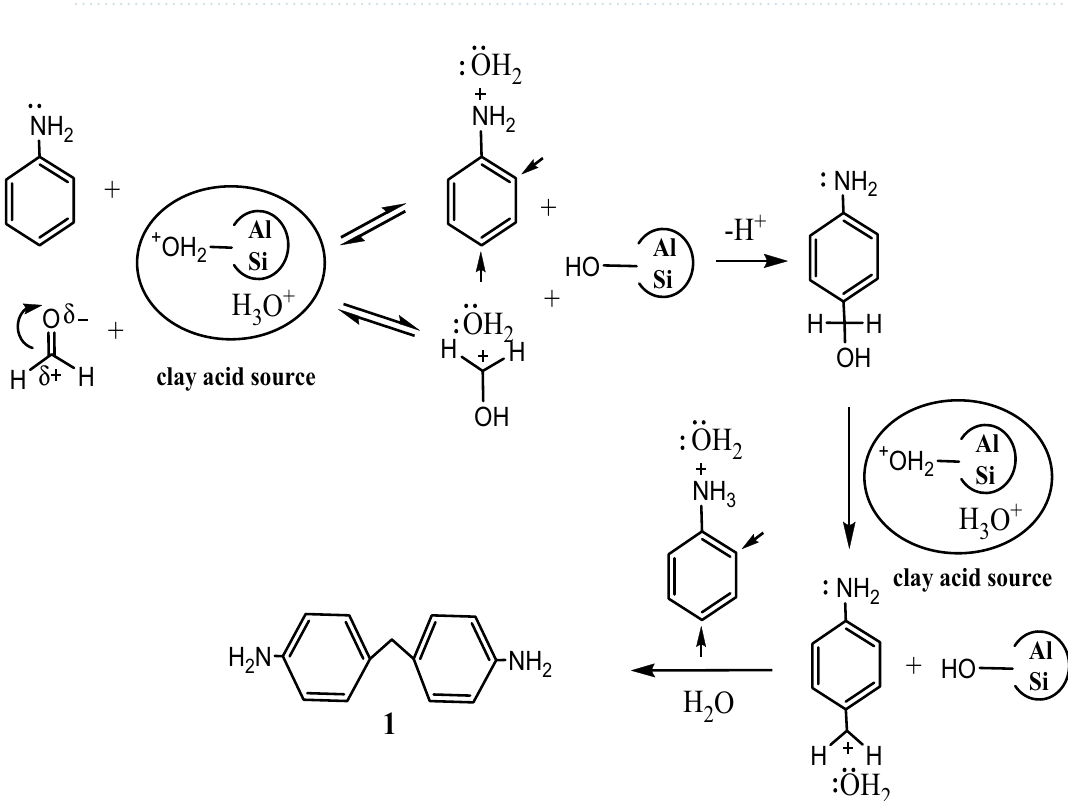
Figure 2. Proposed mechanism of the kaolinite-catalyzed synthesis of diamine